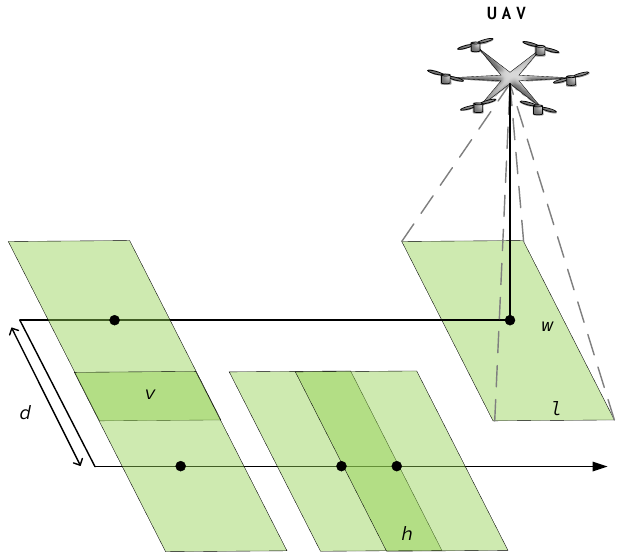
Figure 5. Camera parameters: length l and width w . Overlap Options: h and v denote the percentage of horizontal and vertical overlap of images. Each new frame is marked in green.